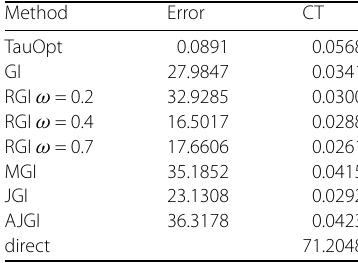
Table 2 Error and CT for Example 5.2